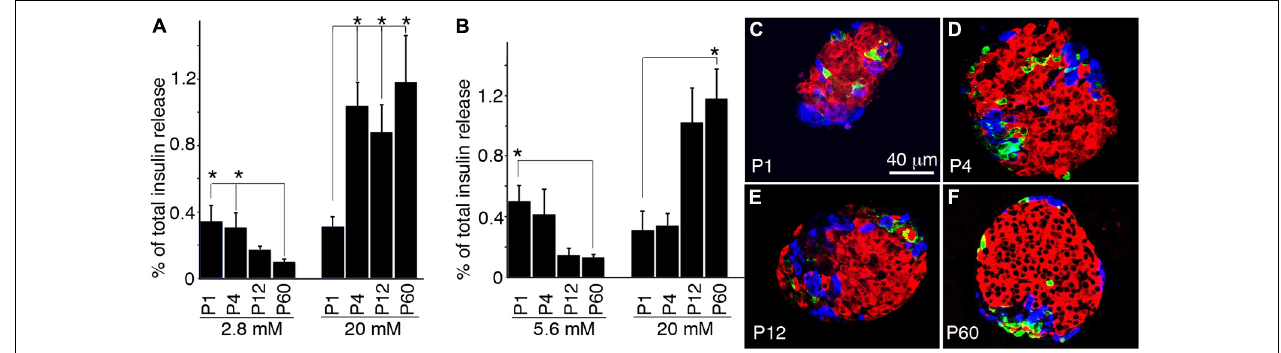
FIGURE 5 | Temporal development of GSIS during β -cell maturation. Hand-picked wild-type islets were used to recover for 2 h before GSIS and immunoassays. For GSIS, the percentages of total insulin from starting islets released in a 45-min window are shown. For all assays, n ≥ 4 independent GSIS assays were done. (A) Islet GSIS for islets preincubated 2.8 mM glucose for 1 h. (B) GSIS after islet preincubated in 5.6 mM glucose for 1 h. (C–F) Morphologies of typical isolated islets. Shown are single-confocal planes of whole-mount islets or pancreatic sections that were co-stained for insulin (red), glucagon (blue), and somatostatin (green). *FDR-adjusted p ≤ 0.05, Wilcoxon rank-sum test ( n ≥